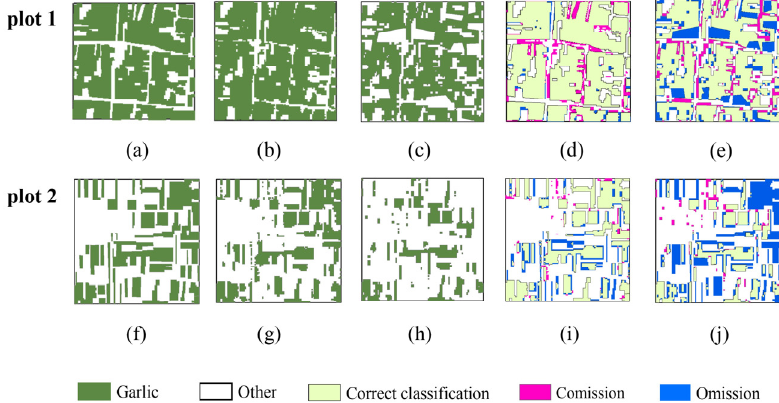
Figure 5. Results of accuracy validation based on two validation quadrats with an area of 1 km by 1 km. ( a , f ) The ground truth quadrats. ( b , g ) The garlic extraction results in February. ( c , h ) The garlic extraction results in September. ( d , i ) Accuracy validation results in February. ( e , j ) Accuracy validation results in